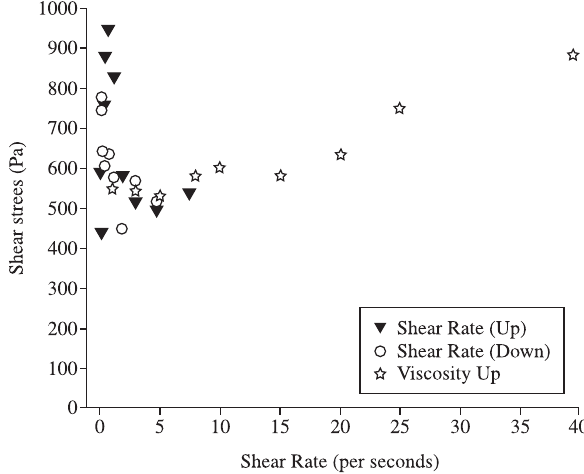
Figure 4. Shear stress as a function of shear rate of sample 2, measured using cone and plate rheometer and capillary extrusion.